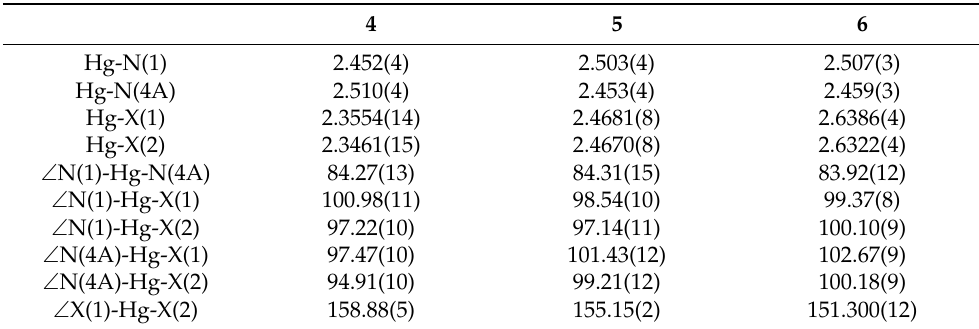
Figure 5. A representative drawing showing the dinuclear structures of 4 (X = Cl), 5 (X = Br), and 6 (X = I). Symmetry transformations used to generate equivalent atoms: (A) − x + 1/2, − y + 1/2, − z + 1 for 4 , − x + 1/2, − y + 3/2, − z + 1 for 5 and 6 . Table 1. Selected bond lengths (Å) and angles (°) for complexes 4 (X = Cl), 5 (X = Br), and 6 (X = I).